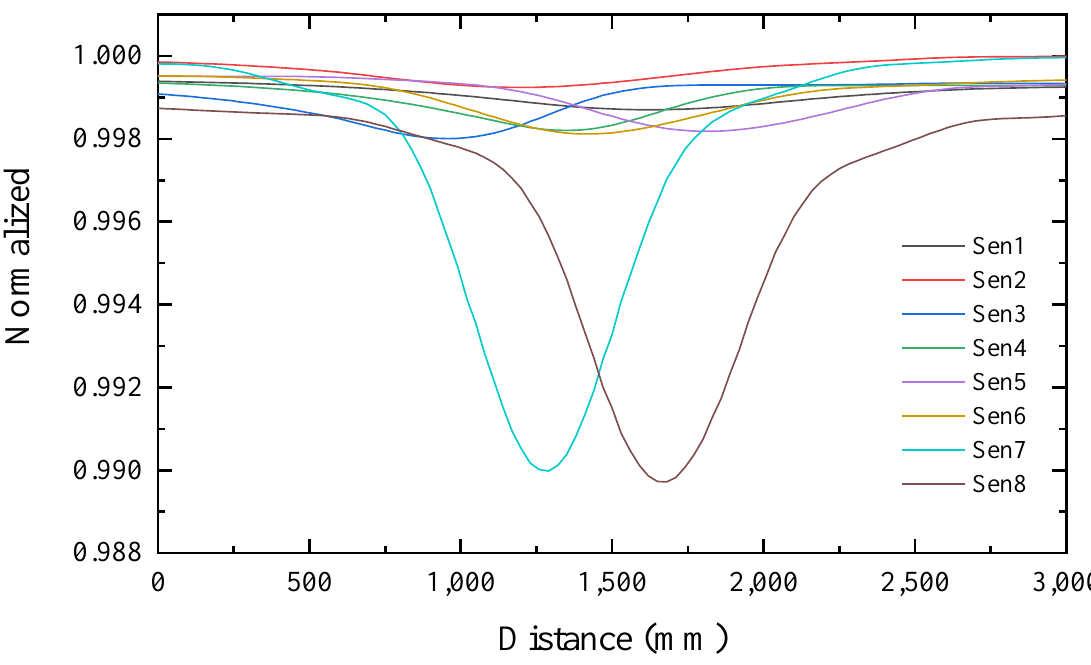
Figure 9. Normalized total field distribution plot.